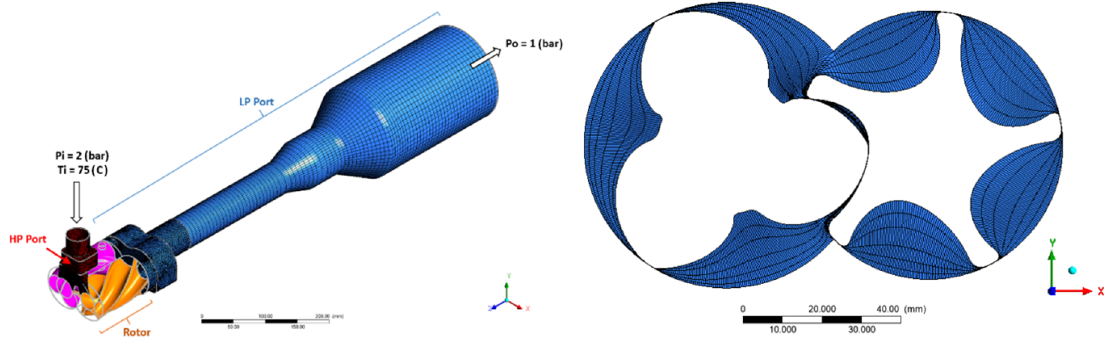
Figure 5. CFD domains with surface mesh for the GL51.2-M twin-screw expander.